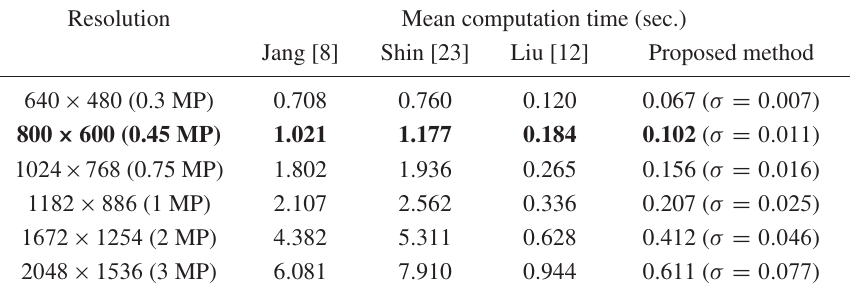
Table 3. Mean computation time of different algorithms with images of various resolutions. The standard deviation ( (cid:27) ) of the computation time for the proposed technique is also given.